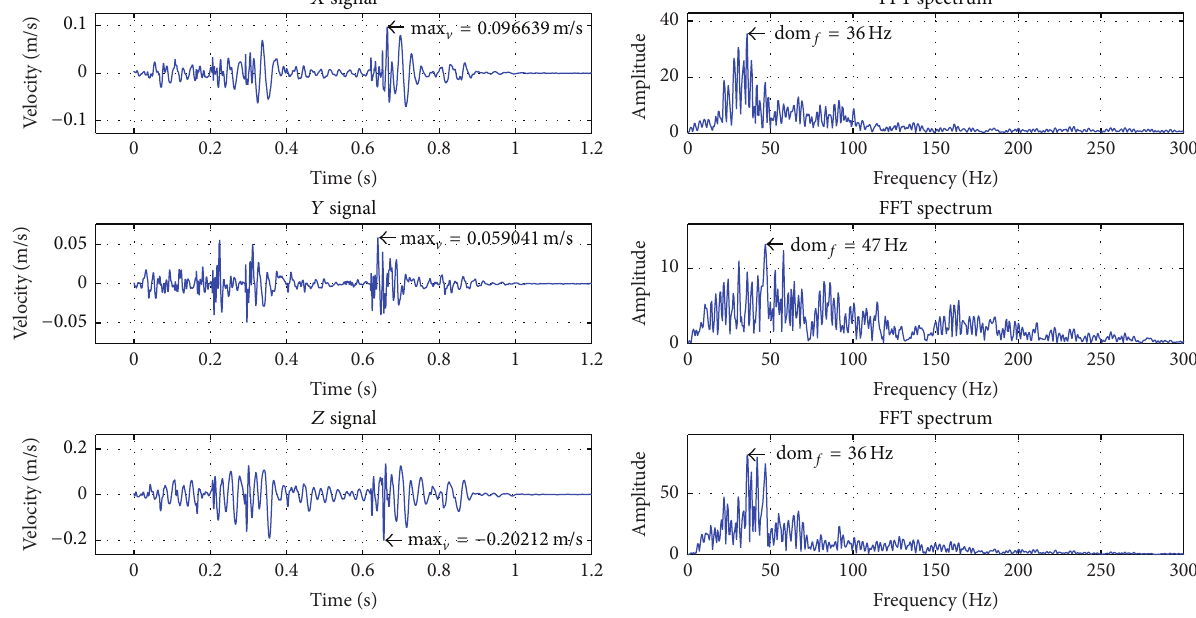
Figure 5: Waveform and spectrum (WBV).